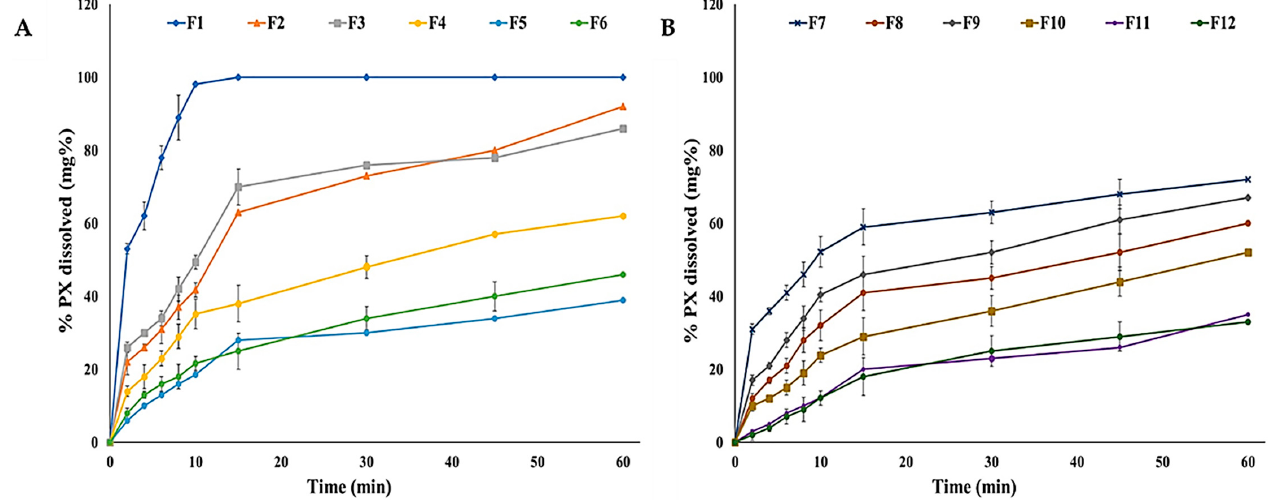
Figure 4. Dissolution profiles of the prepared ( A ) pectin and ( B ) CMC OFDFs loaded with PX nanosuspension.